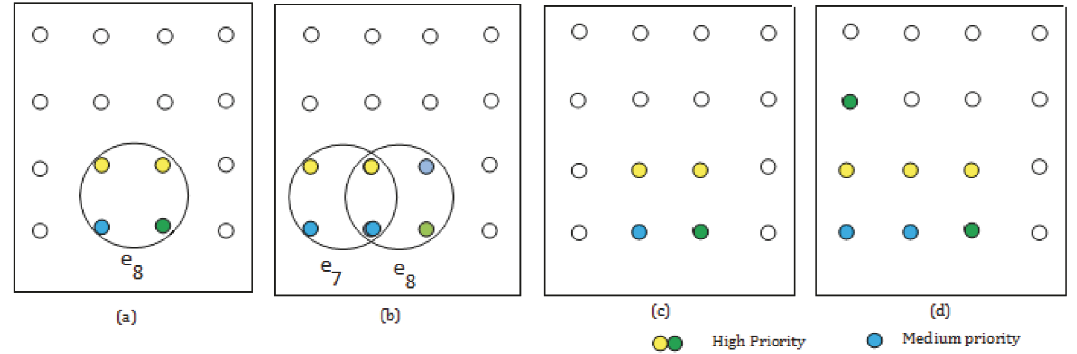
Figure 2: Results of adjunction(a) 𝑋 𝑒 , (b) 𝜀 𝑒 (𝑌 𝑛 ) , (c) 𝛿 𝑛 (𝑋 𝑒 ) , and (d) 𝑌 𝑛 .